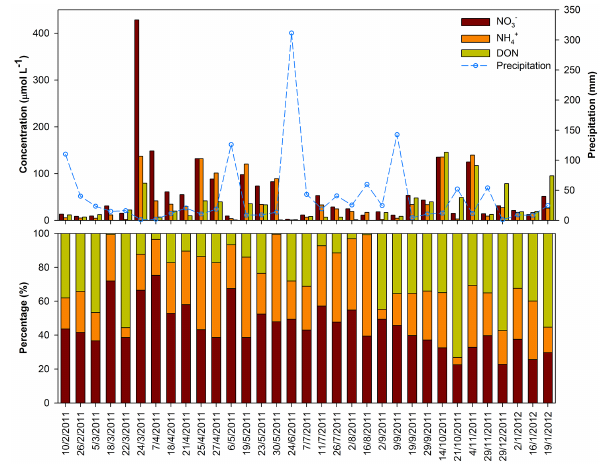
Figure 2. Concentrations (top) and percentages (bottom) of each reactive nitrogen species in precipitation samples collected at Uljin from 2011 to